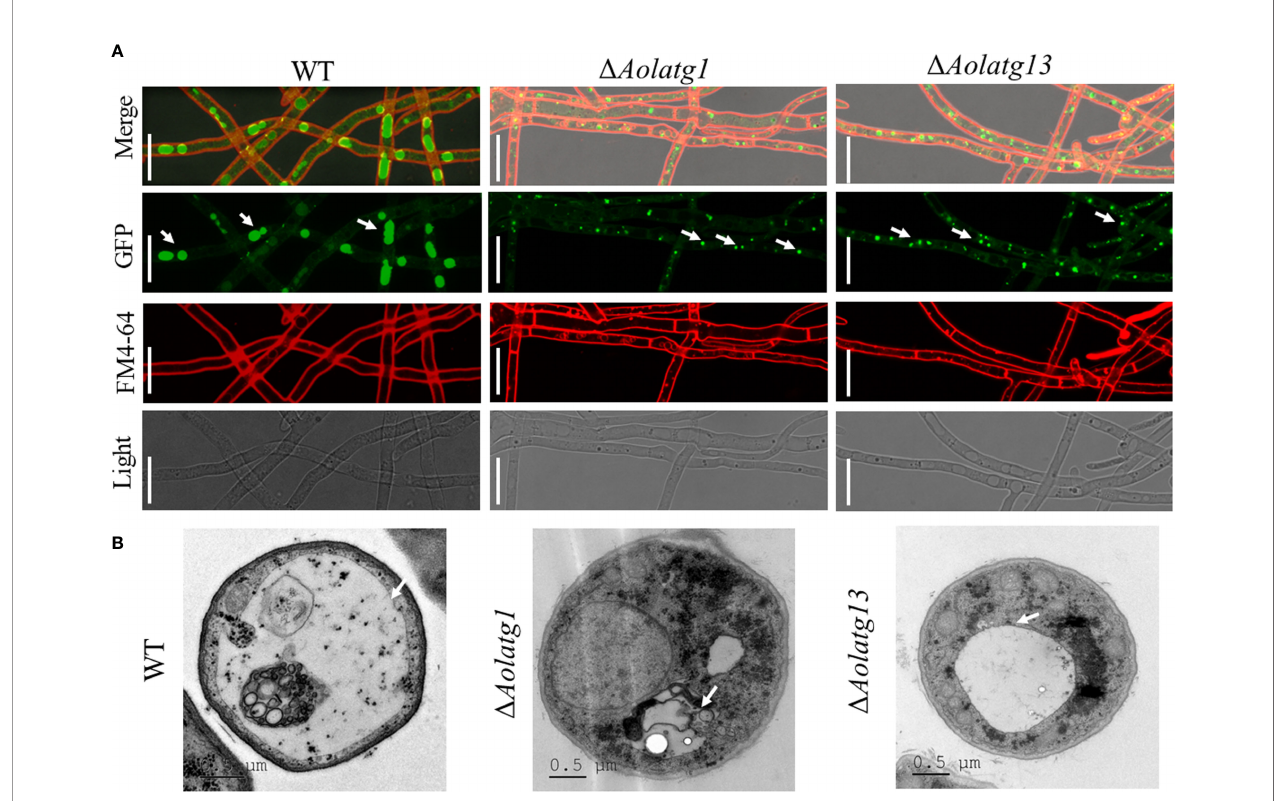
FIGURE 4 | Comparison of the autophagy process in the WT and mutant strains of A. oligospora . (A) Expression of the GFP-Atg8 protein in the WT and mutant strains. The A. oligospora strains were grown in the liquid CM medium at 28°C for 24 h, and then transferred to the liquid MM-N medium for 6 h. The vacuoles were stained by FM4-64 and examined by fl uorescence microscopy. White arrow: GFP signals. Scale bars = 10 µm. (B) The vacuoles of hyphal cells were observed using transmission electron microscopy. Arrows indicate the vacuole. Scale bars = 0.5